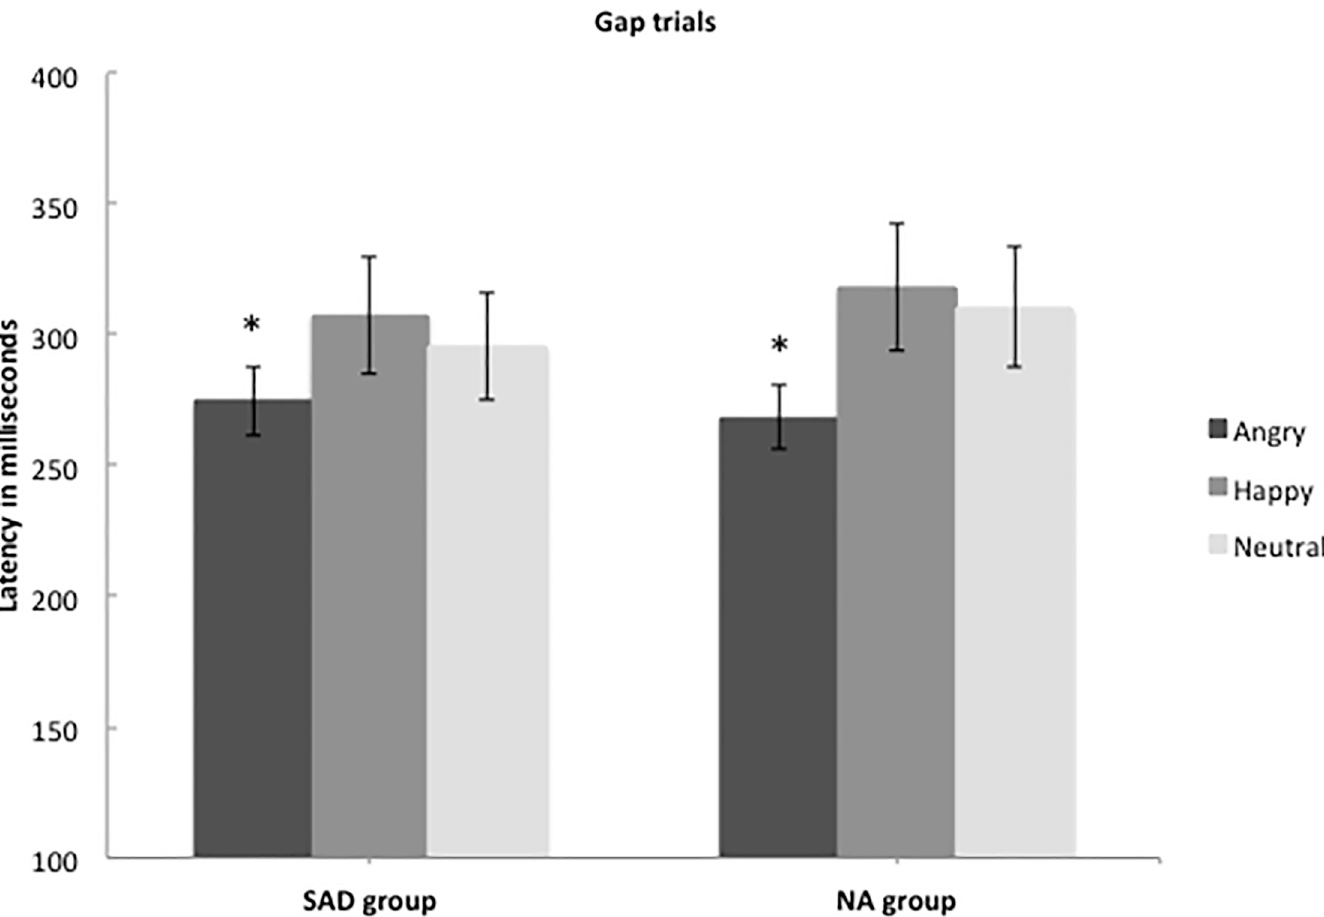
Fig 3. Mean time in milliseconds (with 95% confidence intervals) to fixate gaze on a peripherally appearing social stimulus with different emotional valences. For the social anxiety group ( N = 25) and the non-anxious group ( N =